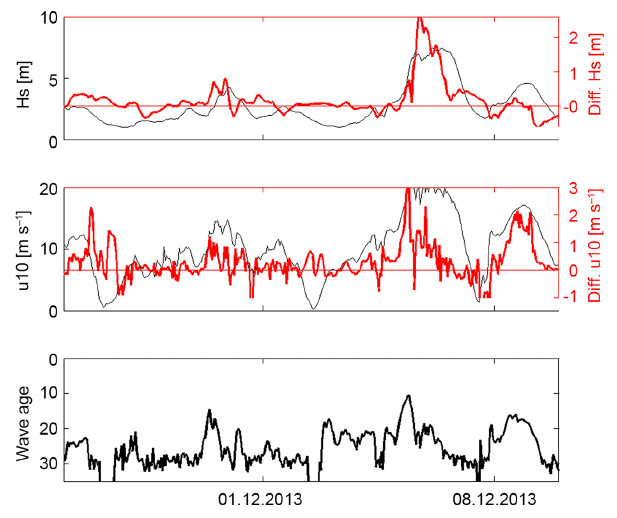
Figure 13. As Fig. 12 but during storm